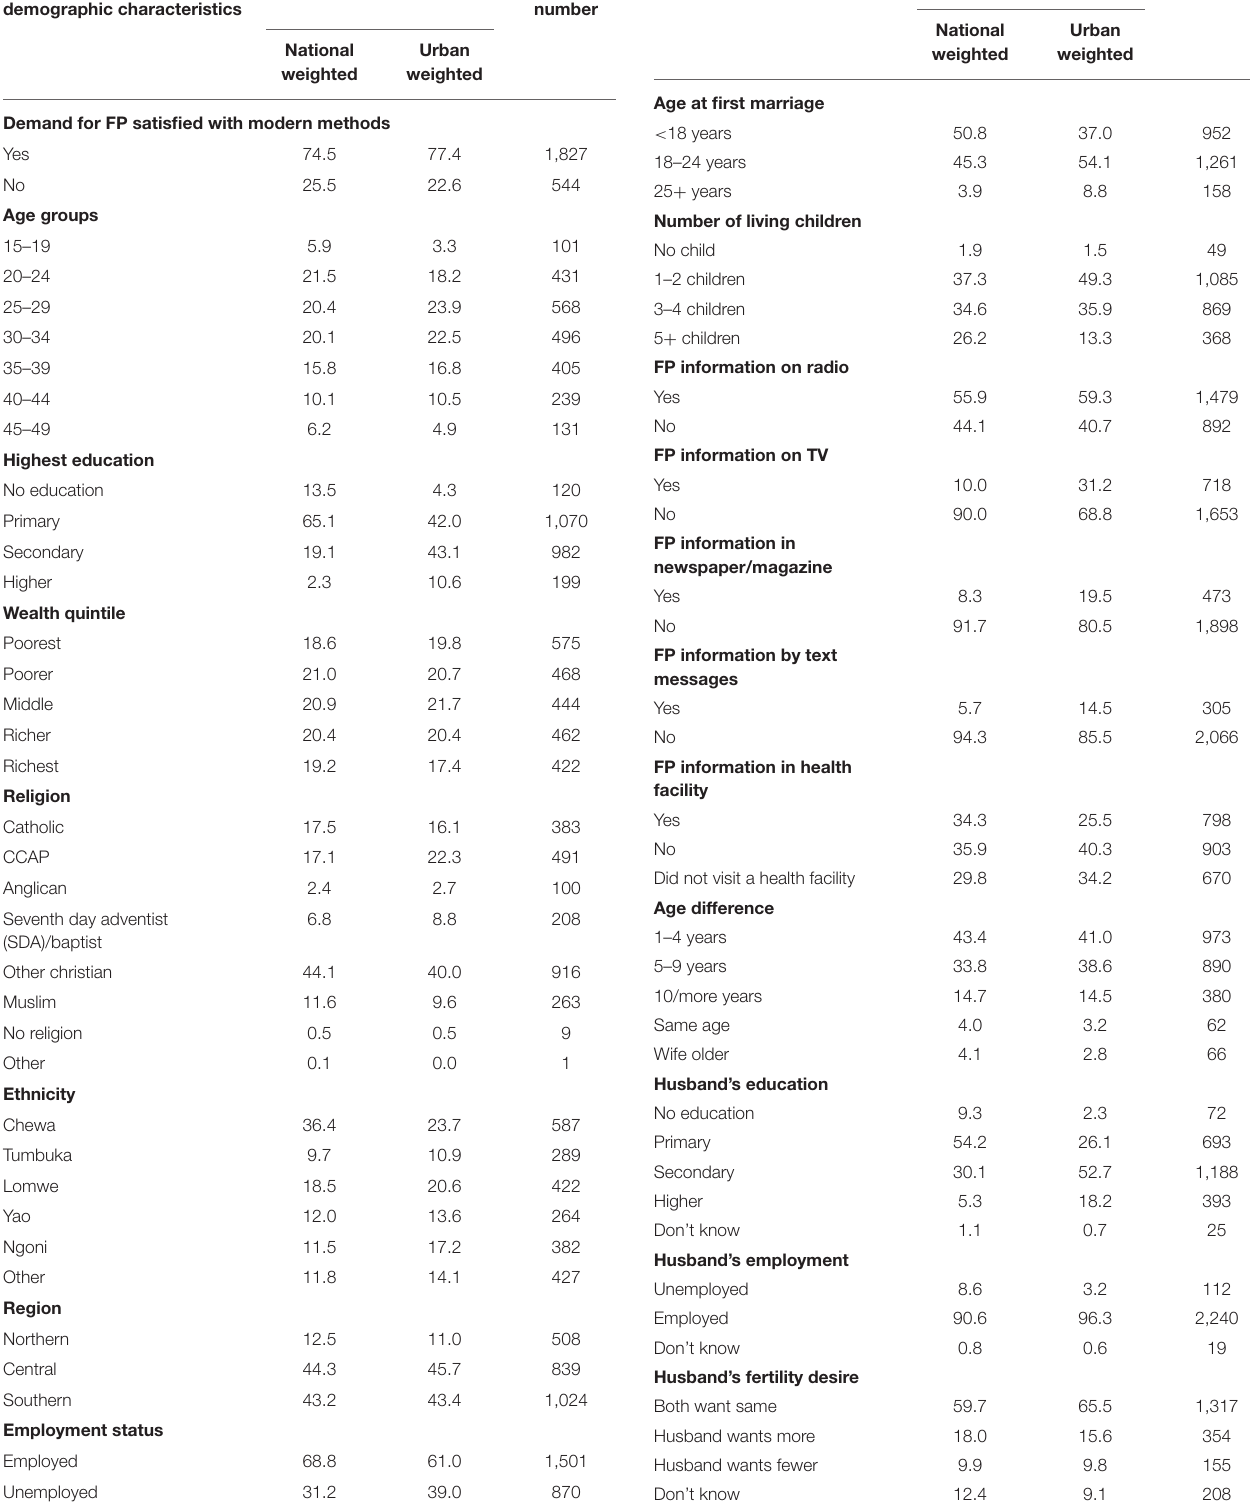
TABLE 2 | Socio-demographic characteristics of married women with demand for FP in Malawi. Socioeconomic and demographic characteristics